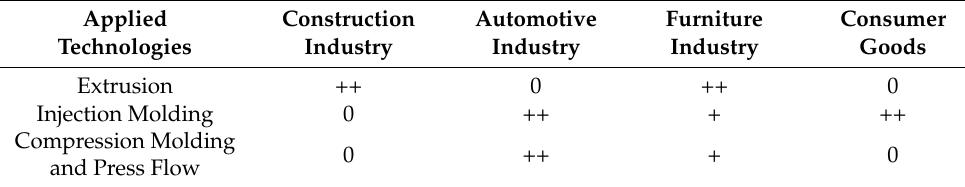
Table 1. The most important industries and their preferred technologies